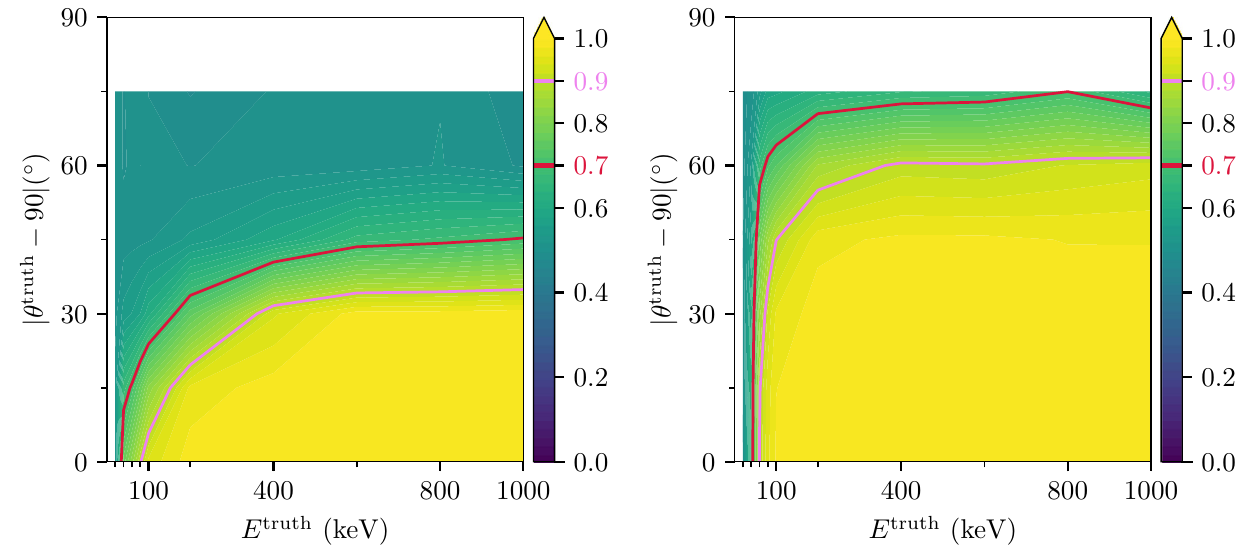
Table 2 Efficiencies for the quality checks of each step of ptr for the beam-on sample ( (cid:8) data ) and the simulated sample used in the performance study ( (cid:8) sim ). Step numbers refer to the labeled panels in Fig. 6. The efficiencies are cumulative, so that the last row gives the total